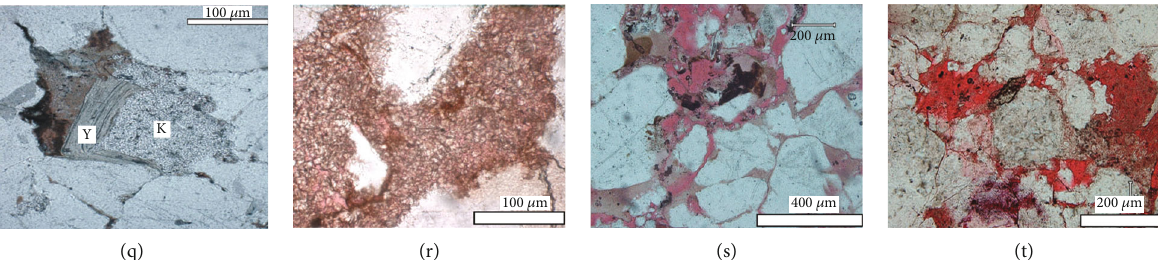
Figure 3: The typical diagenetic characteristics of sandstone reservoirs under microscope in the southwestern Ordos Basin. (a) Oriented mica and clastic particles and primary pores, Qingshen 2 well, Shan 1 section, 4733 m, (-); (b) bending deformation of clay minerals, Zitan 1 well, He 8 section, 3740.51m, (+); (c) linear contact and concave-convex contacts between particles, He 3 well, Shan 1 section, 4146.16m, (+); (d) concave-convex contacts of particles, He 3 well, He 8 section, 4079.88m, (+); (e) quartz overgrowths and siliceous cements, Qingtan 2 well, Shan 1 section, 4705.68m, (+); (f) authigenic quartz microcrystal, Zhentan 1 well, Shan 1 section, 4381.13m, (-); (g) scaly illite aggregates fi lling intergranular pores, Qingshen 2 well, Shan 1 section, microscope; (h) fl aky illite fi lling intergranular pores, Qingshen 2 well, Shan 1 section, SEM; (i) kaolinite microcrystalline aggregates fi lling pores, preserving morphology of feldspar and other clastic particle. Zhentan 1 well, Shan 1 section, microscope; (j) vermicular kaolinite fi lling intergranular pores, Zhentan1 well, Shan 1 section, SEM; (k) calcite cement, Ling 1 well, Shan 1 section, 3698.60m, (+); (l) micrite calcite cement, He 3 well, Xiashihezi section, 4081.68m, (+); (m) feldspar metasomatized by micrite with remnant twining, Zhentan 1 well, Shan 1 section, 4379.07 m, (+); (n) metasomatic micrite and clay minerals with the morphology of lithic particles, Lian 1 well, Shan 1 section, 3469.69m, (+); (o) quartz metasomatized by sparry calcite cement, He 3 well, Shan 1 section, 4146.62m (+); (p) lithic particles metasomatized by fl aky illite, He 3 well, Shan 1 section,